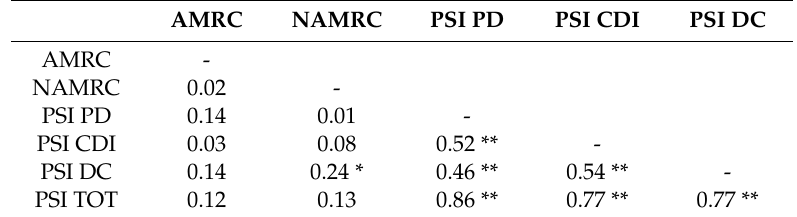
Table 3. Spearman’s intercorrelations between mind-mindedness and the parenting stress of mothers participating in the